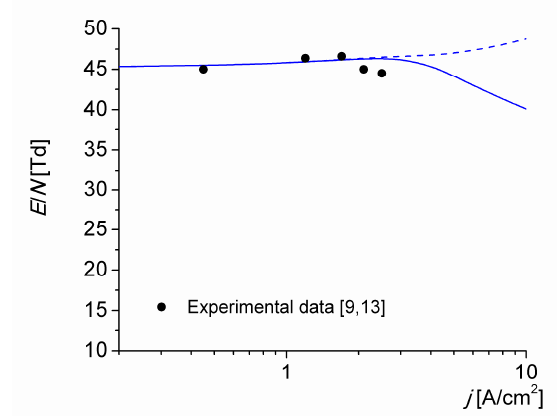
Figure 6. Reduced electric field in the discharge versus the discharge current density for T 0 = 1800 K. Calculations with (solid line) and without (dashed line) associative ionization reactions (R14)–(R16) and (R18).